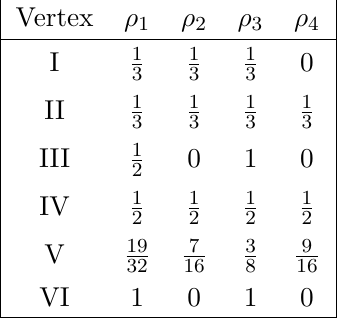
Table 2 . Vertices of the orbit space of the self-couplings of S in the 15 of